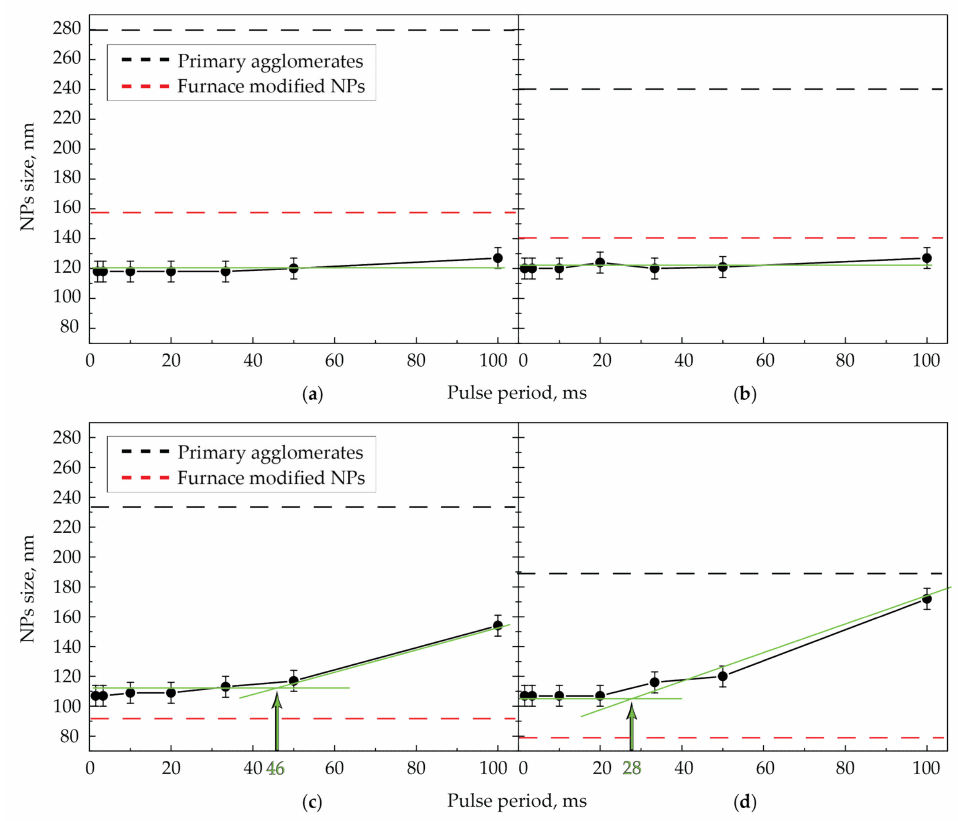
Figure 5. Dependencies of NPs size at the output of the cell on pulse repetition period of laser radiation with the wavelength of 1053 nm at the maximum pulse energy of 900 µ J and the gas flow rates of ( a ) 50, ( b ) 100, ( c ) 200, and ( d ) 400